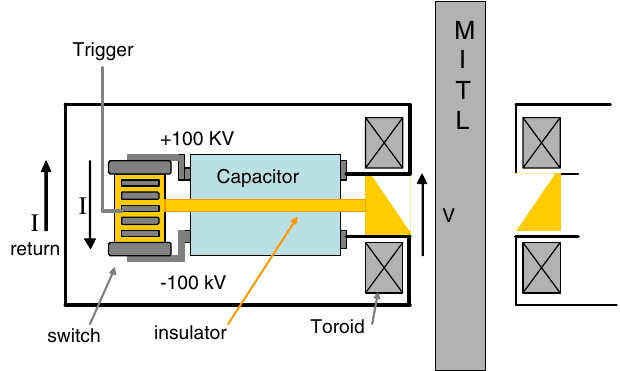
FIG. 1. (Color) Schematic of basis LTD brick driving MITL